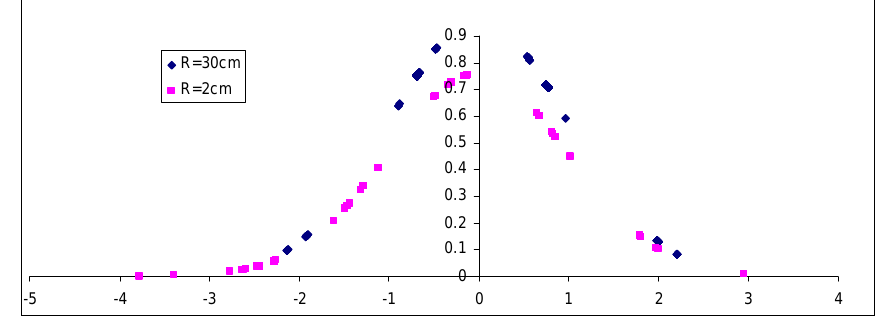
Figure 13. The probability density function (pdf) of a normal population for R = 30 cm and R = 2